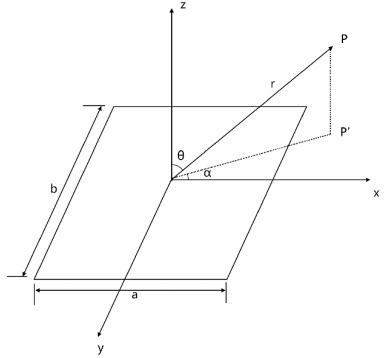
Figure 5. A single rectangular plunger.